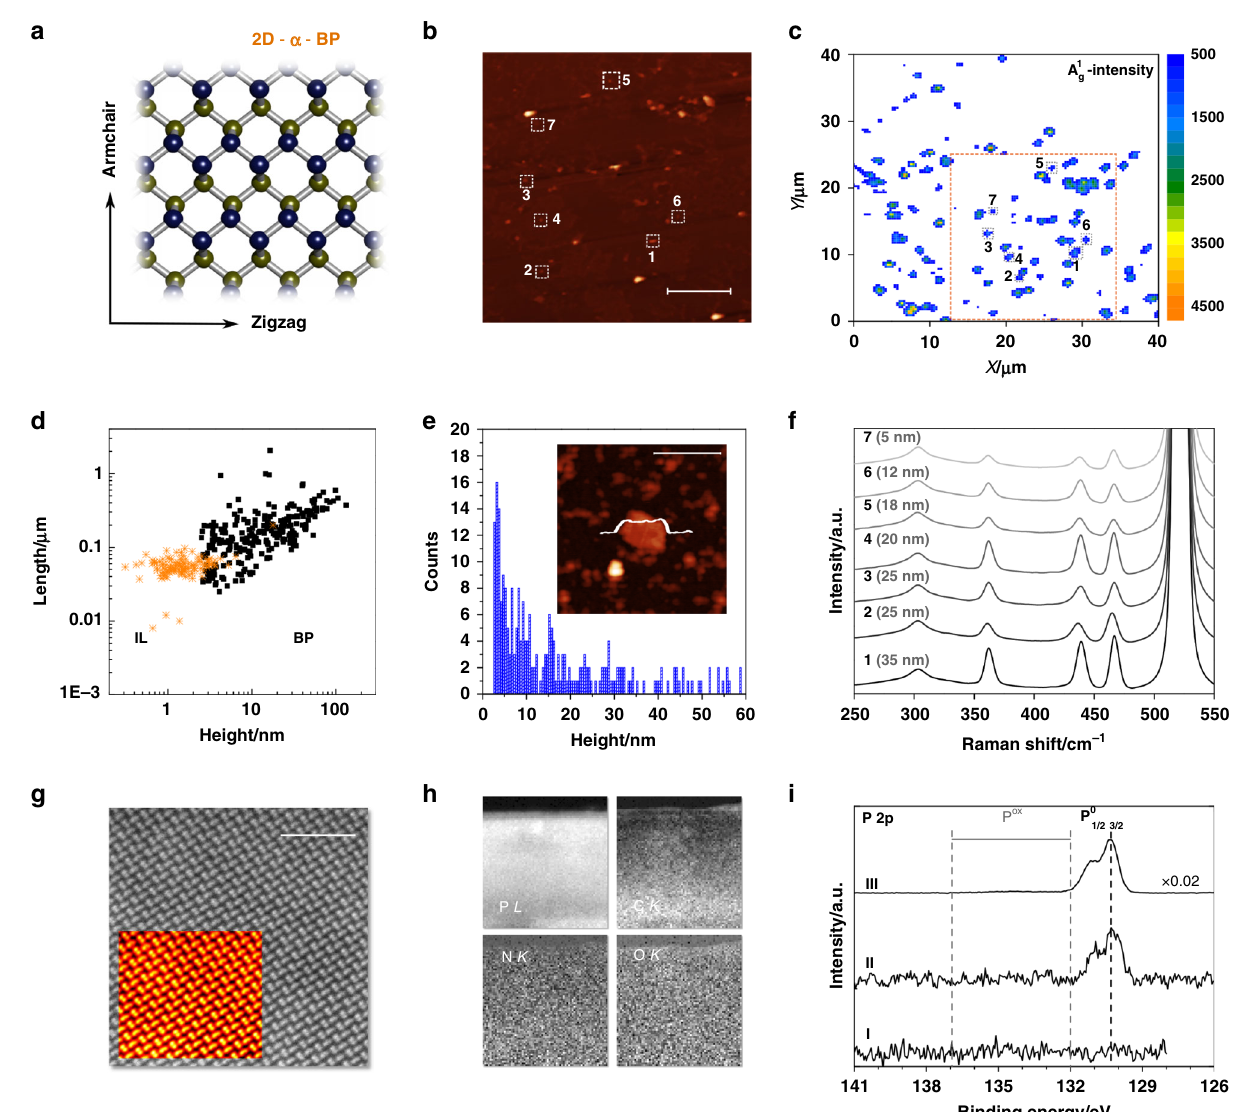
Fig. 1 Characterization of exfoliated black phosphorus. a Top view of the orthorhombic structure (C mce space group) of BP. Upper plane P atoms marked in blue, lower plane in yellow. b Representative AFM topography image (inset, scale bar 5 µ m) of the exfoliated sample spin-coated onto SiO 2 /Si substrates. c The corresponding Raman A 1 g ( λ exc = 532 nm) mapping of the same BP fl akes (>14,000 single point spectra over a surface area of 40 µ m 2 using a step size of 0.5 µ m). The numbers denote the areas in which the Raman spectra shown in ( f ) were recorded. d Plot of the nanosheet length as a function of the fl ake height (obtained from AFM) considering a total amount of 252 replicates as well as the data corresponding to the IL blank (sample size = 116) Supporting Information S8 and 9). e Histogram of the apparent thickness of the exfoliated FL-BP obtained from AFM (sample size = 252). The inset shows an AFM image of a nanosheet along with its corresponding height pro fi le of ca . 6 nm (inset, scale bar 400 nm). f Raman spectra of the nanosheets indicated in b and c (the numbers labeling the spectra in f correspond to the nanosheets marked by numbers in b and c ). g Atomic resolution HAADF image acquired down the [110] axis, from the edge of a free-standing portion of a fl ake. The inset exhibits the raw image and a Fourier fi ltered (FFT) version, in false color. The scale bar represents 2 nm. h Compositional maps derived from electron energy-loss spectroscopy (EELS)